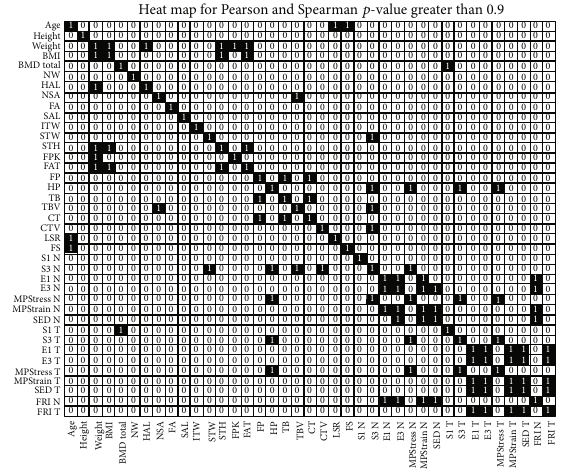
Figure 6: Heat map result of joining the information provided by Person ’ s and Spearman ’ s indices: the black squares represent a correlation higher than 0.9 while the white zeros indicate that the threshold is not